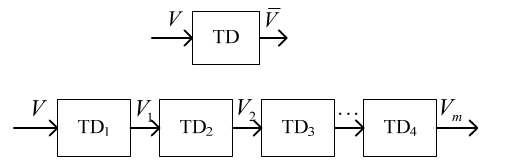
Figure 5. Comparison between track-differentiator and track-differentiator